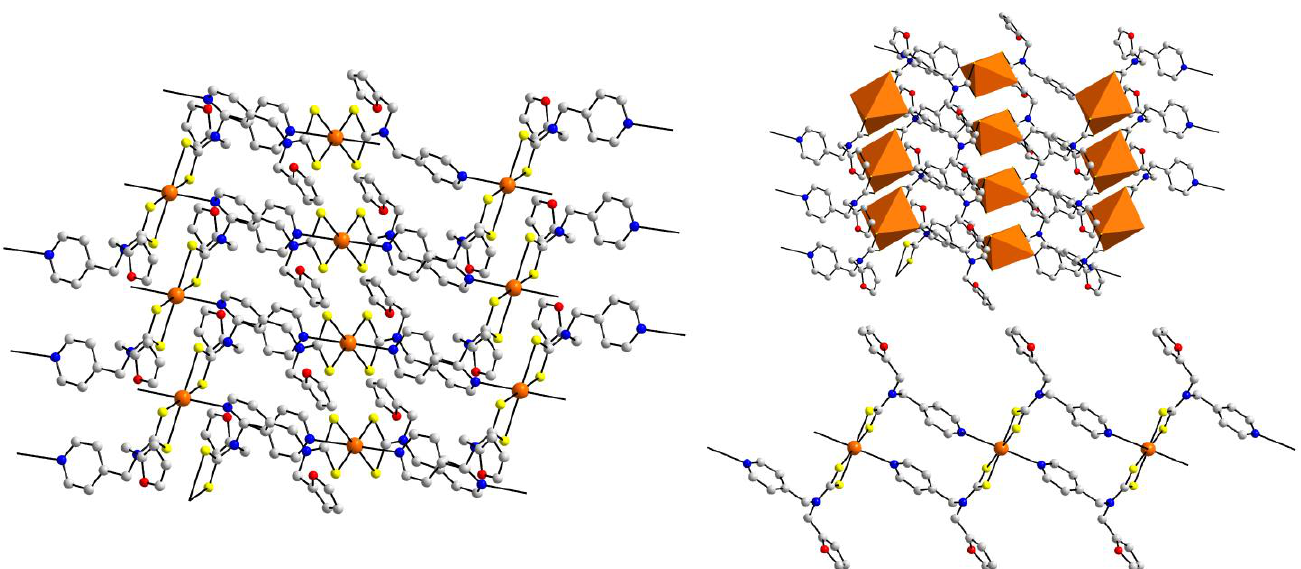
Figure 16. Views of the two-dimensional array in the crystal of [Hg(L 9 ) 2 ] n ( 51 ); one plan view highlights the arrangement of the coordination polyhedra.